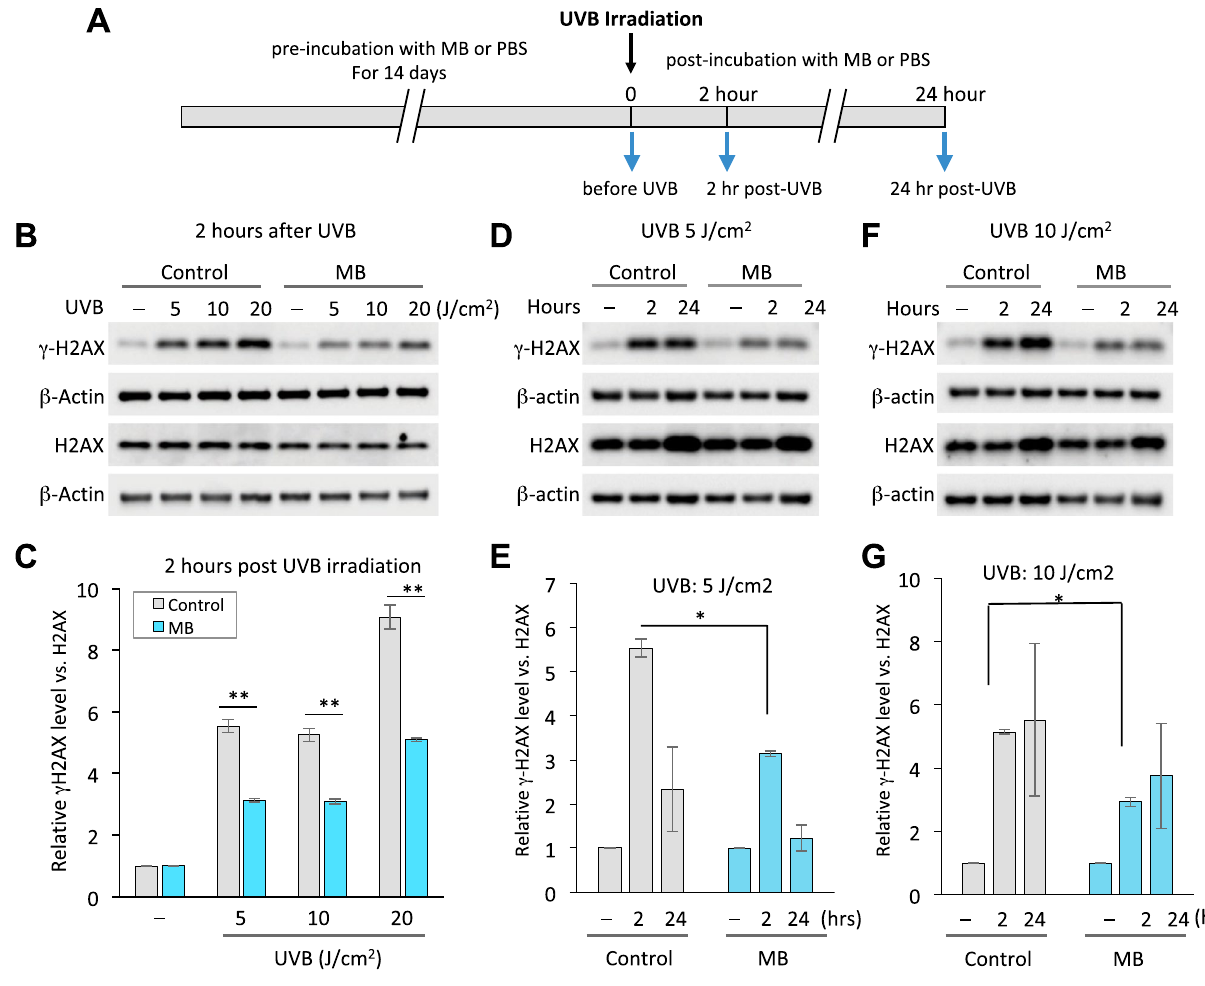
Figure 1. MB alleviates DNA damage induced by UVB irradiation in human keratinocytes. ( A ) Schematic diagram showing the experimental timeline starting from pre-incubation of keratinocytes with 100 nM MB or PBS for 2 weeks, then exposure to UVB light, and ending with cell pellets collection before irradiation (time 0), and 2 or 24 h post-irradiation for Western blotting analysis. ( B ) Representative Western blotting images with anti-γH2AX, H2AX, and β-actin antibodies showing DNA damage response after 2 h of UVB irradiation at different dosages. No UVB control is designated as “ ⎯ ”. ( C ) Quantification of γH2AX band intensities shown in ( B ), which is normalized to total H2AX. * p < 0.05; ** p < 0.01 MB versus Control at the same dose. ( D , F ) Representative Western blotting images with anti-γH2AX, H2AX, and β-actin antibodies in human keratinocytes. The cell pellet samples were collected at 0, 2, or 24 h after UVB irradiation at 5 J/cm 2 ( D ) or 10 J/cm 2 ( F ). Zero hour control is designated as “ ⎯ ”. ( E , G ) Quantification of γH2AX band intensities shown in ( D , F ), which is normalized to total H2AX. * p < 0.05; MB versus Control at the same time MB-treated cells was found (Fig. 3C). In contrast, no significant changes in ROS levels were observed in the BP-3 treated cells compared to Dimethyl Sulfoxide (DMSO)-treated controls, indicating BP-3 is not a ROS scavenger. To further investigate MB’s capability as a ROS scavenger and UVA protective agent for the skin, we obtained four human skin fibroblast cell lines from young male, old male, young female, and old female donors (Detailed cell line information in Supplemental Table S1). We evaluated the effectiveness of MB in comparison with Vita- min A and Vitamin C, both of which are popular antioxidants in skincare products 15 . We first monitored the cell proliferation for a 2-week time frame. In this experiment, we observed that MB enhanced the cell proliferation greatly in all four lines with comparable effectiveness to Vitamin C (Fig. 4A,B). Vitamin A, conversely, did not affect the cell proliferation rates (Fig. , B). The combination of MB and Vitamin C synergistically boosted the cell proliferation capacities even higher in all four lines (Fig. 4A,B). Next, we measured the final mitochondrial ROS after a four-week treatment period. Surprisingly, MB was the only treatment that consistently reduced the mitochondrial ROS in all four cell lines. The combination of MB and Vitamin C worked more effectively in old fibroblasts in ROS clearance, while in young cell lines, this combination has less of an effect (Fig. 4C,D). MB is non‑toxic to coral health as compared to Oxybenzone (BP‑3).